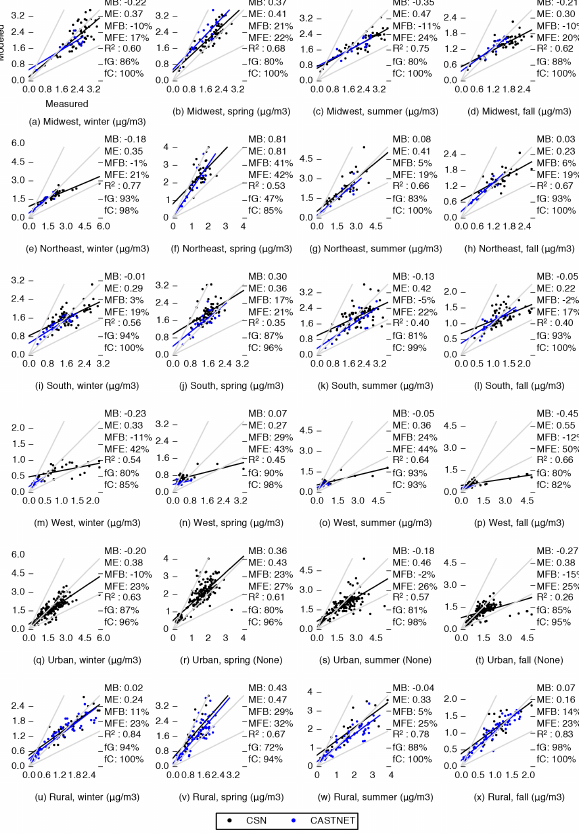
Figure 7. Comparison of modeled and measured particulate SO 4 concentrations, disaggregated by region and season.